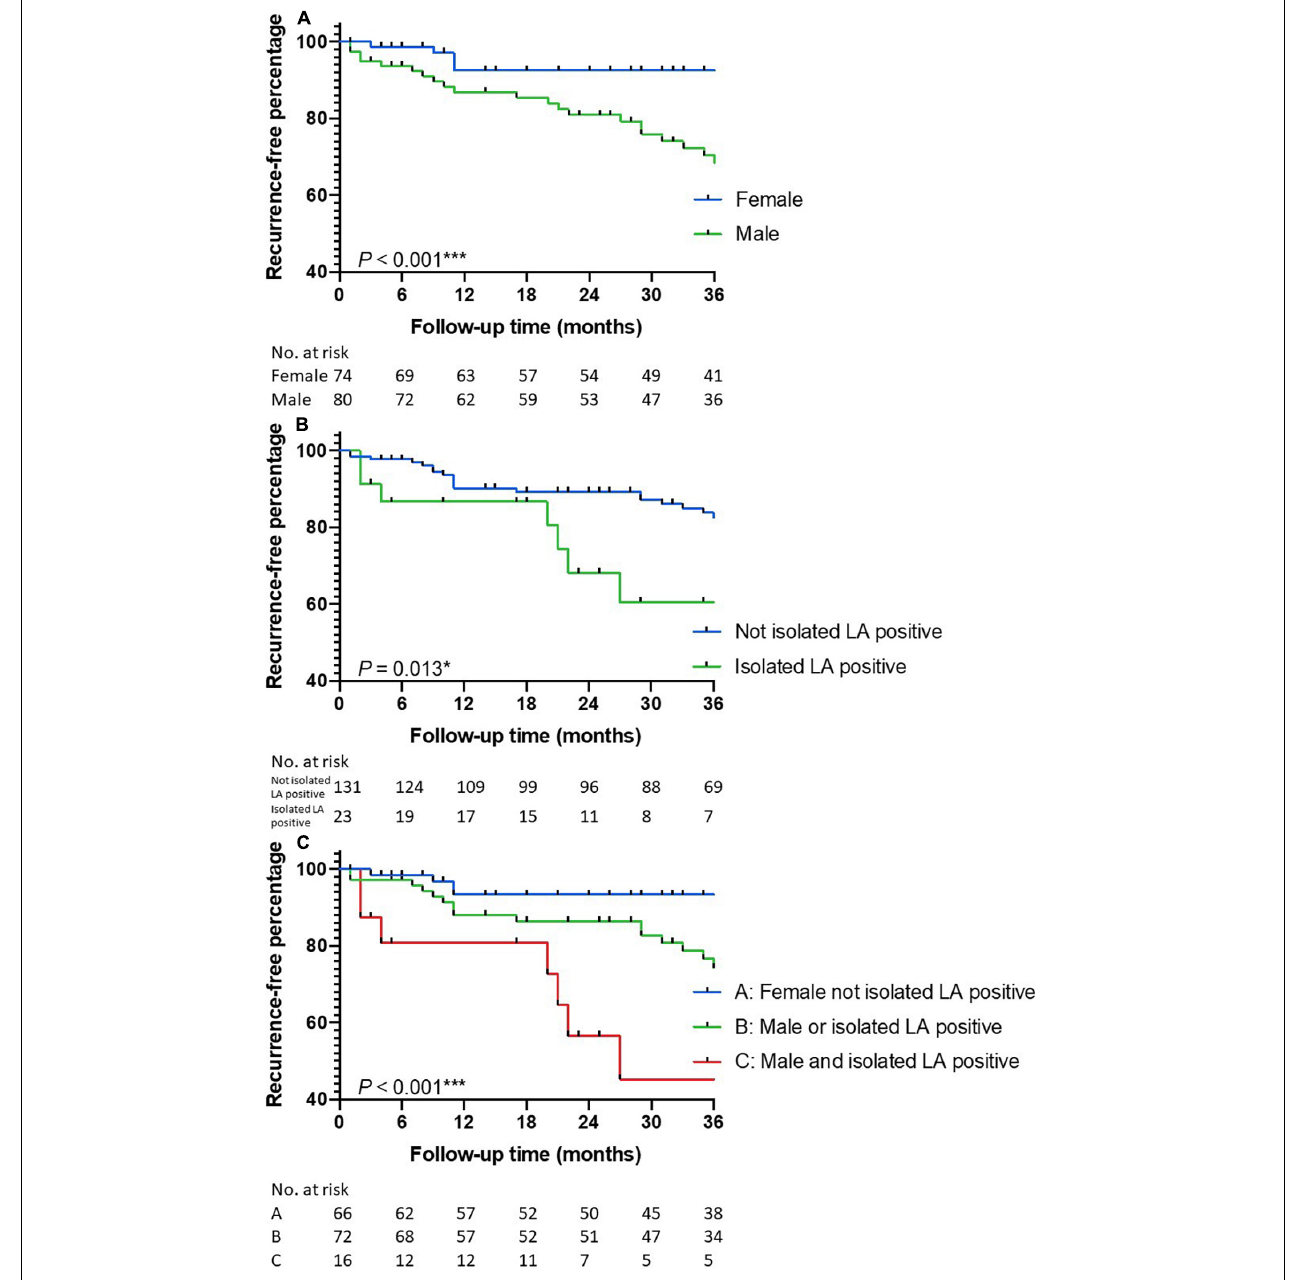
FIGURE 3 | The Kaplan–Meier curves for thromboembolic recurrence. Groups were defined by (A) gender, (B) isolated LA positivity, and (C) risk stratification by gender and isolated LA positivity. LA, lupus